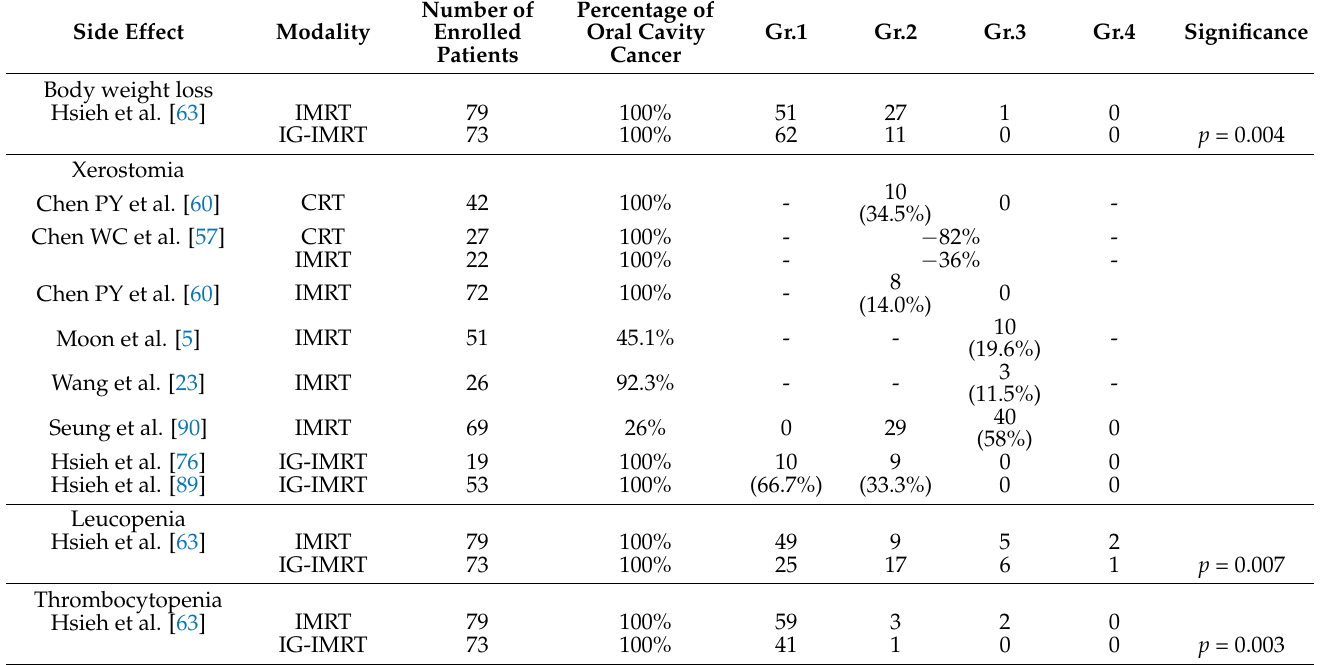
Table 4. Treatment-related adverse effects with intensity-modulated radiotherapy and image-guided intensity-modulated